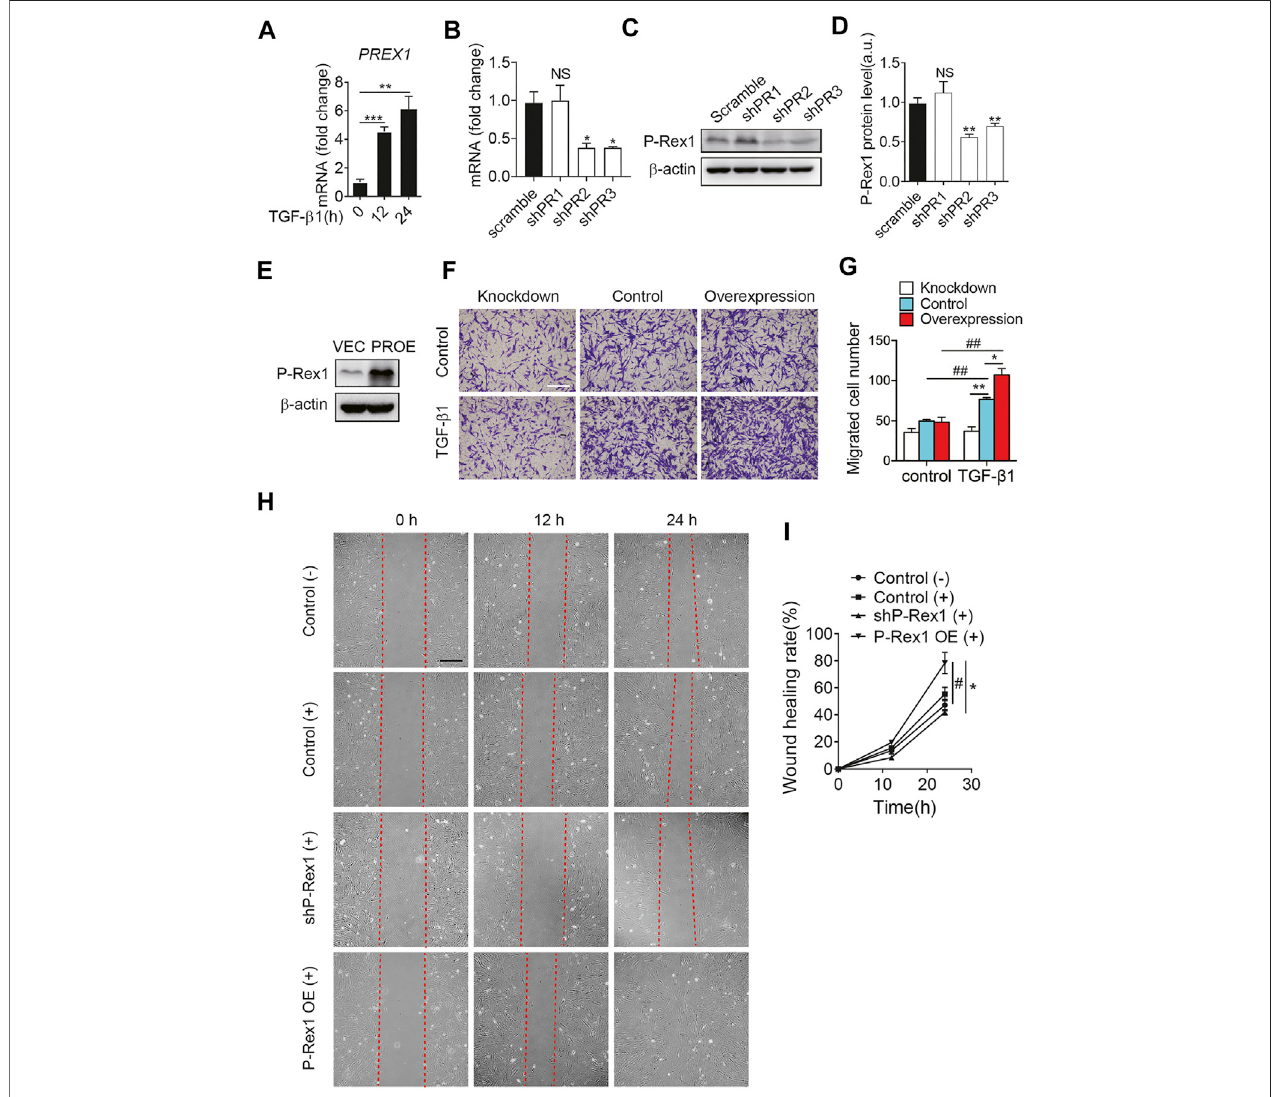
FIGURE 2 | P-Rex1 is involved in mouse lung fi broblast migration. (A) The transcript for PREX1 was determined after TGF- β 1 stimulation for the indicated time (hour) in mouse lung fi broblasts. Knockdown (B – D) and overexpression (PROE) (E) of P-Rex1 in lung fi broblasts were constructed using recombinant lentiviral transfection.RT-qPCRanalysisandWesternblotwereperformedtoverifythelevelofP-Rex1. (F) TGF- β 1(10 ng/ml)orbuffercontrolinducedcellmigrationwithP-Rex1 knockdownoroverexpression fi broblasts.Representativeimages of fi broblasts migrated through polycarbonate fi ltermembraneareshown, scalebars (cid:2) 250 μ m. (G) Analysisofmigrationindifferent fi broblasts. (H , I) WoundclosurewithP-Rex1knockdownoroverexpression fi broblaststreatedwith(+)orwithout( − )TGF- β 1(10 ng/ ml) for atotal of24 h. Scale bars (cid:2) 250 μ m. Quantitativedatashown are mean ± SEMfrom three independent experiments (* p < 0.05 and ** p < 0.01comparing P-Rex1 knockdown or overexpression with scrambled control cells; # p < 0.05 and ## p < 0.01 comparing TGF- β 1 – treated cells with untreated cells in the same group).